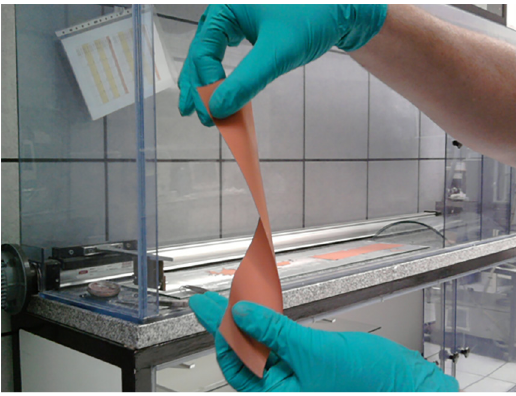
Figure 3. Copper green tape with 3.0 wt% binder.